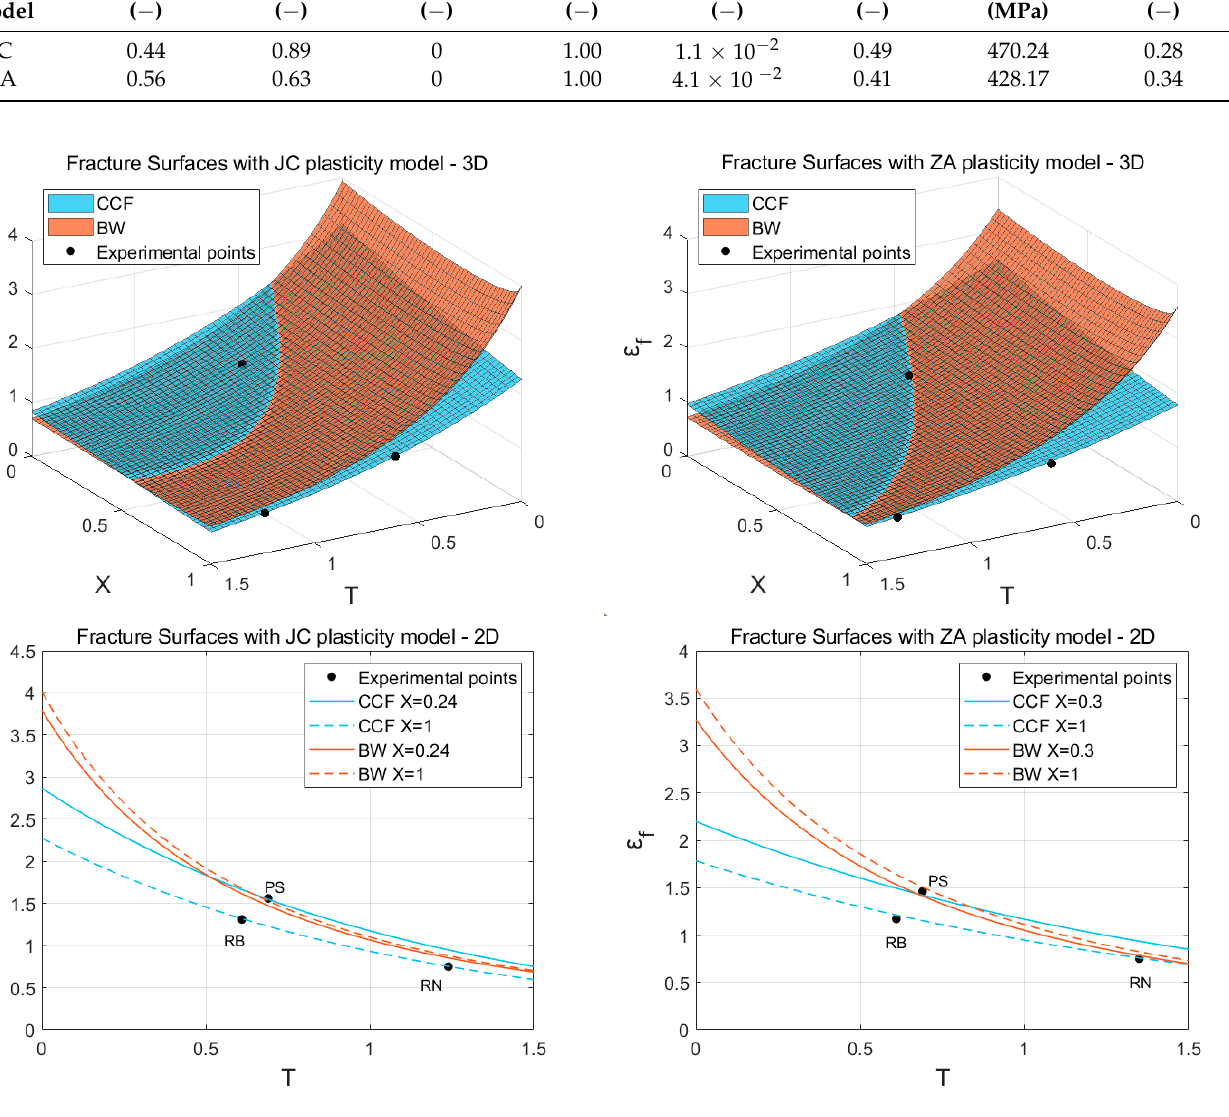
Figure 11. Comparison between the fracture surfaces of BW and CCF, JC and Za plasticity models, and positions of calibration points.